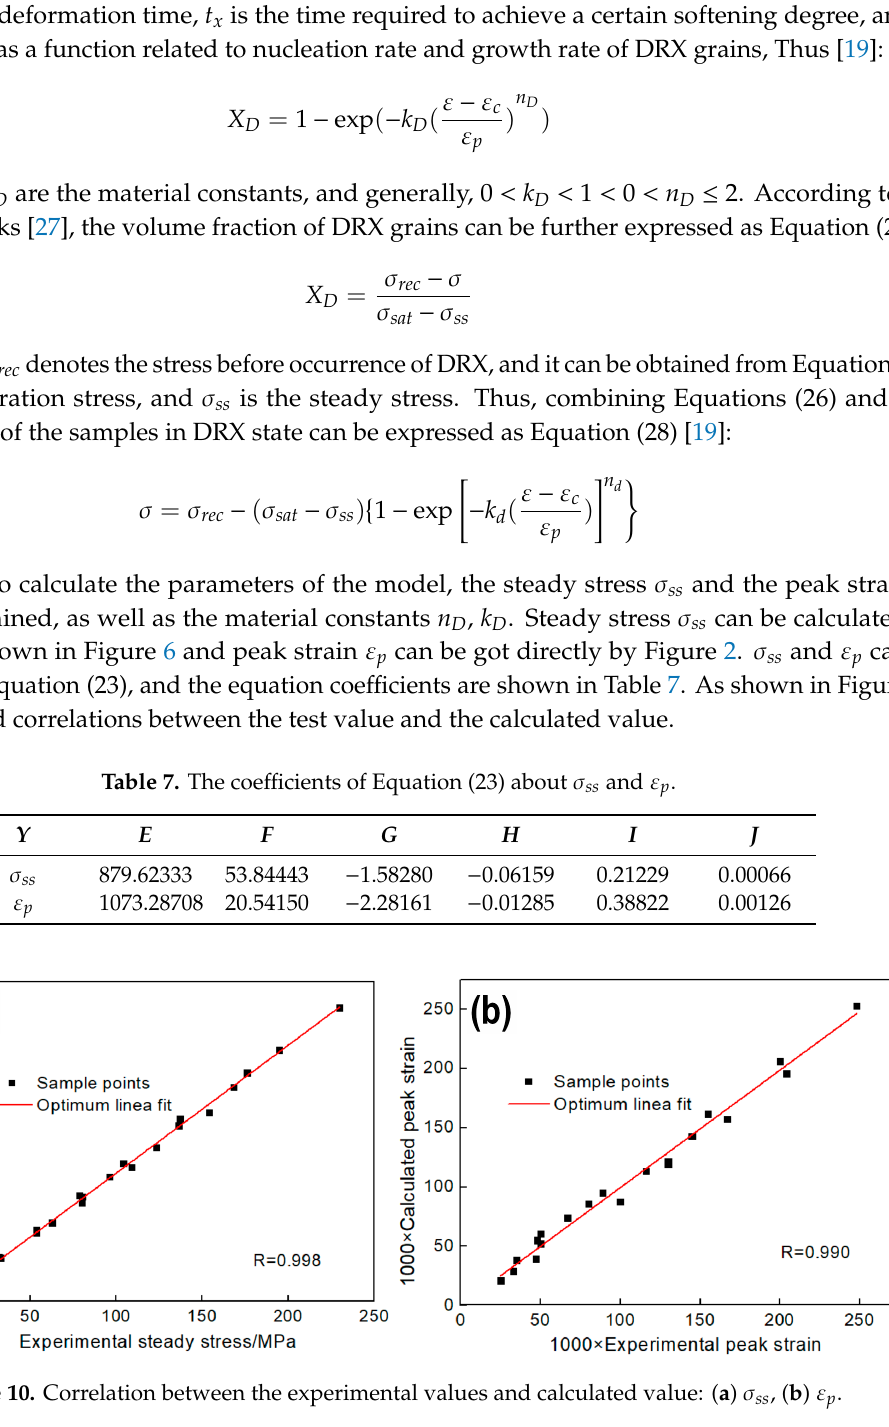
Figure 10. Correlation between the experimental values and calculated value: ( a ) σ ss , ( b ) ε p